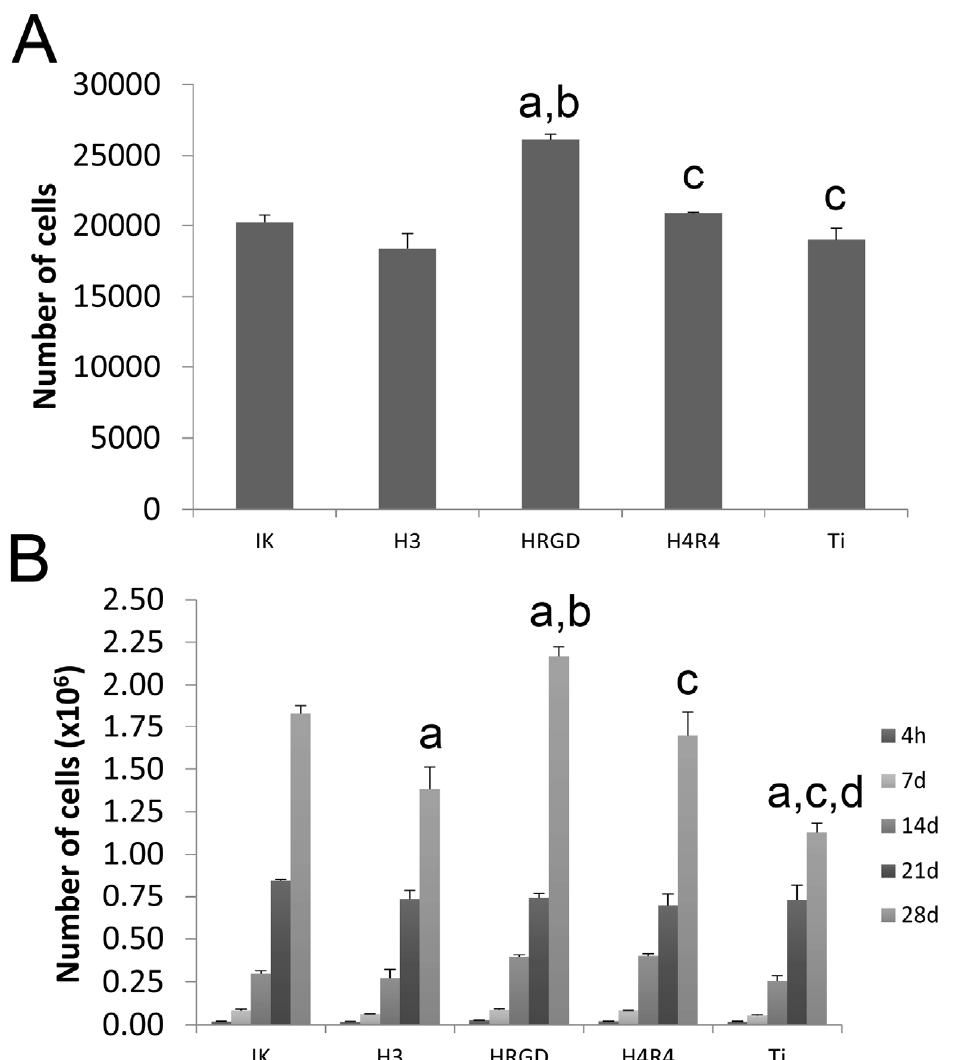
Figure 6. Cell adhesion at 4 h ( A ) and cell proliferation ( B ) of rMSCs on the different functionalized and non-functionalized (Ti) scaffolds. At each time point, “a” indicates statistically significant differences compared to IK, “b” indicates statistically significant differences compared to H3, “c” indicates statistically significant differences compared to HRGD, and “d” indicates statistically significant differences compared to H4R4.